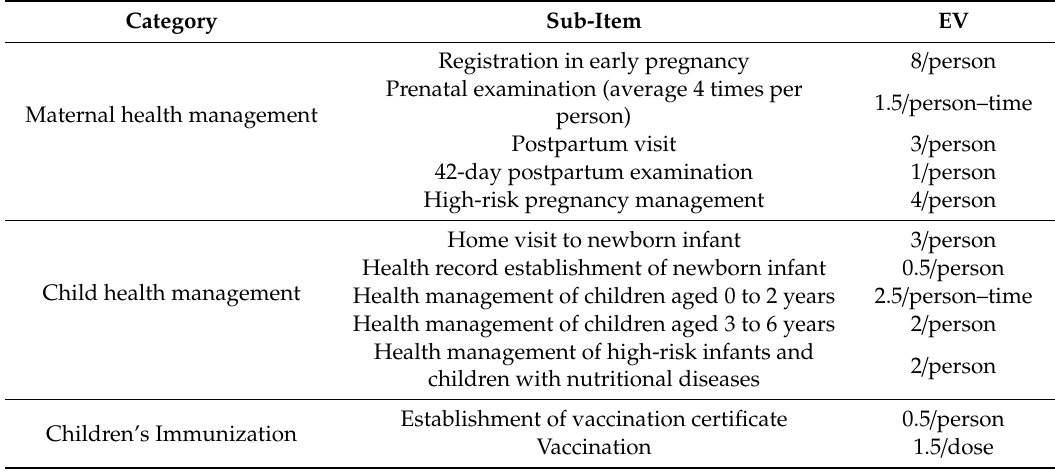
Table 1. The equivalent values (EVs) of related community basic public health services (BPHS) in Zhejiang Province,